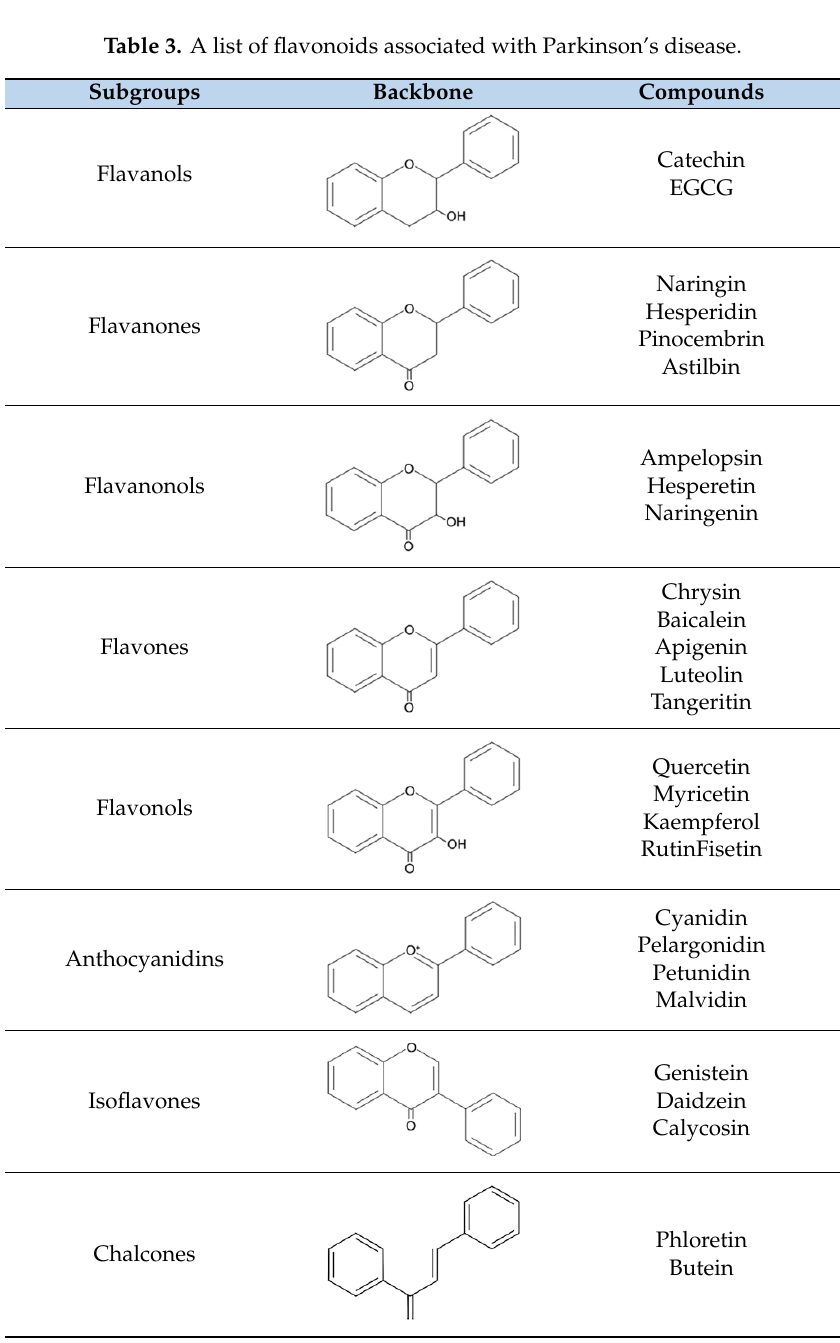
Table 3. A list of flavonoids associated with Parkinson’s disease.